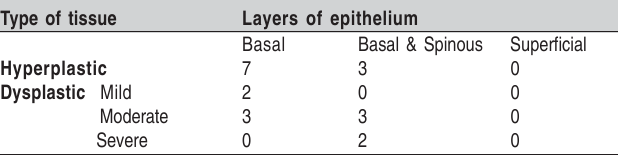
Table 2. Distribution of cases according to predominant localization of p53 cells in the different study groups.